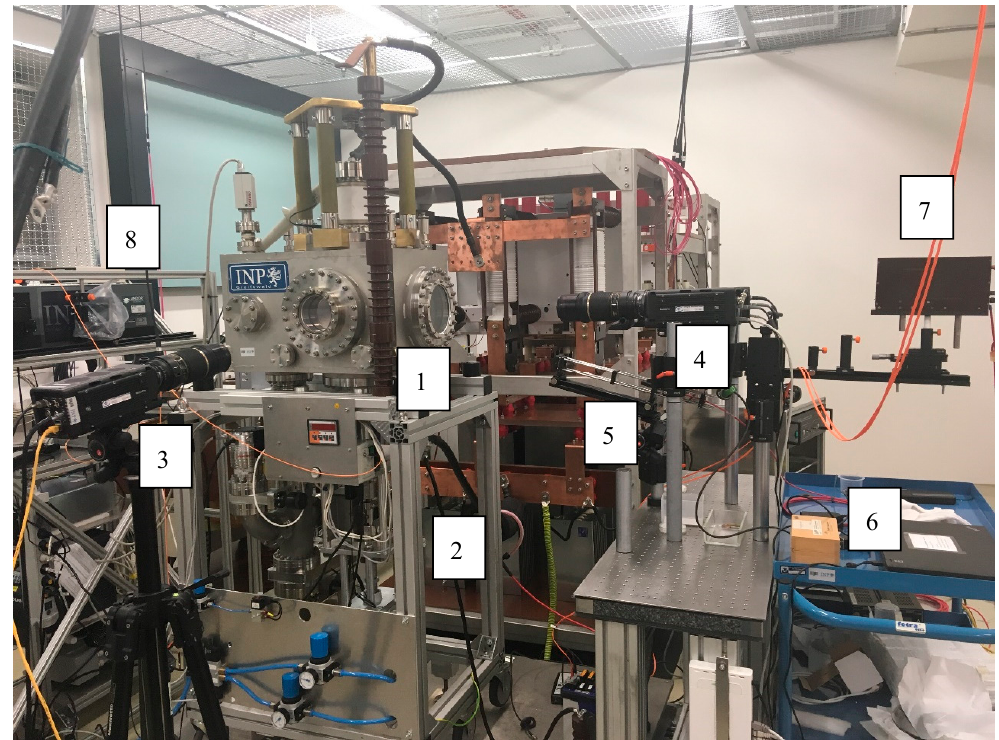
Figure 1. Setup for studies on vacuum arcs: ( 1 ) vacuum chamber, ( 2 ) pumping system, ( 3 ) high-speed camera (general arc dynamics), ( 4 ) two high-speed cameras equipped with narrow-band optical filters, ( 5 ) NIR optics, ( 6 ) NIR spectrometer, ( 7 ) Xe flash lamp, ( 8 ) 0.75 m imaging spectrograph.